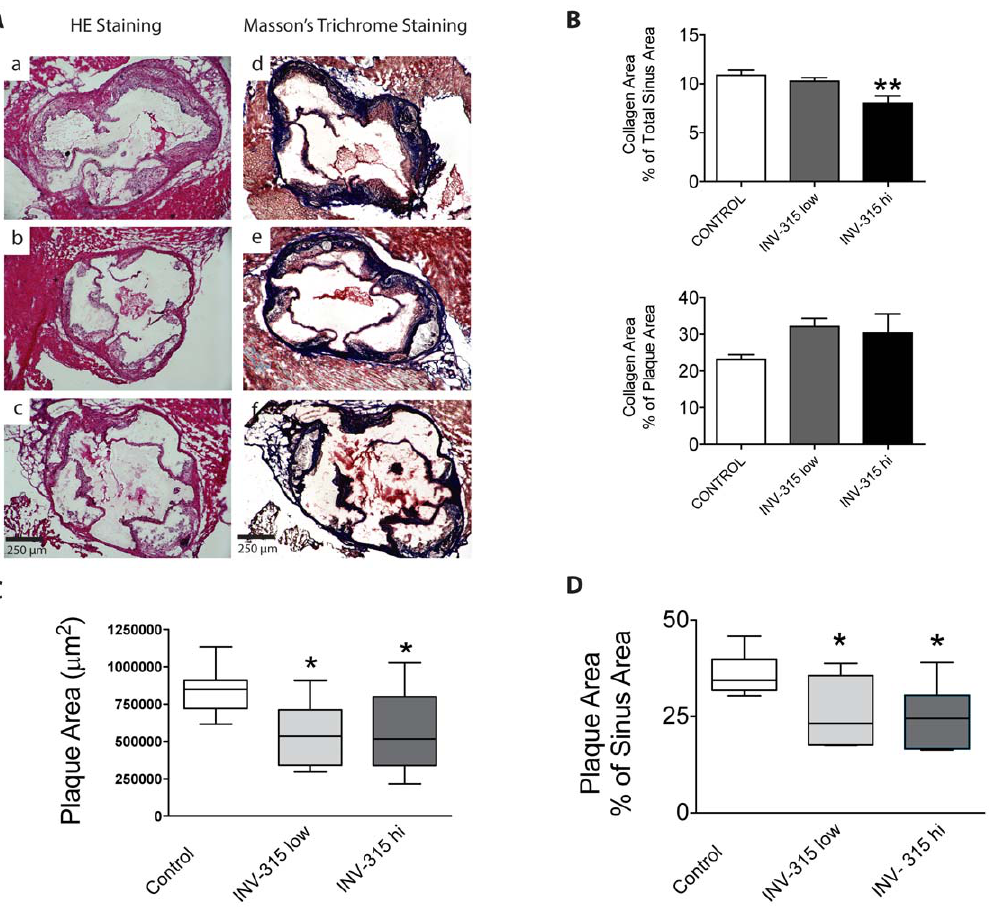
Figure 1. Effects of MPO inhibition on atherosclerosis in ApoE 2 / 2 mice fed on HFD. A. Images of aortic sinus stained with H&E staining and Masson’s trichrome staining from HFD fed ApoE 2 / 2 mice treated with placebo (a and d) as control or low dose (b and e) or high dose (c and f) of INV- 315. B. Collagen content in plaque in 3 groups by Masson-trichrome staining, expressed as percent of collagen area relative to total sinus area or plaque area. Data are mean 6 S.E.M. C and D. Box plot of plaque burden quantified by absolute plaque area (C) and percent of plaque area relative to sinus area (D). The box represents the upper and lower quartiles. The whiskers show the 25 and 75 percentiles, and the line in the box represents the median. P , 0.05, ** P , 0.01 compared with control group. Data from 7–9 different